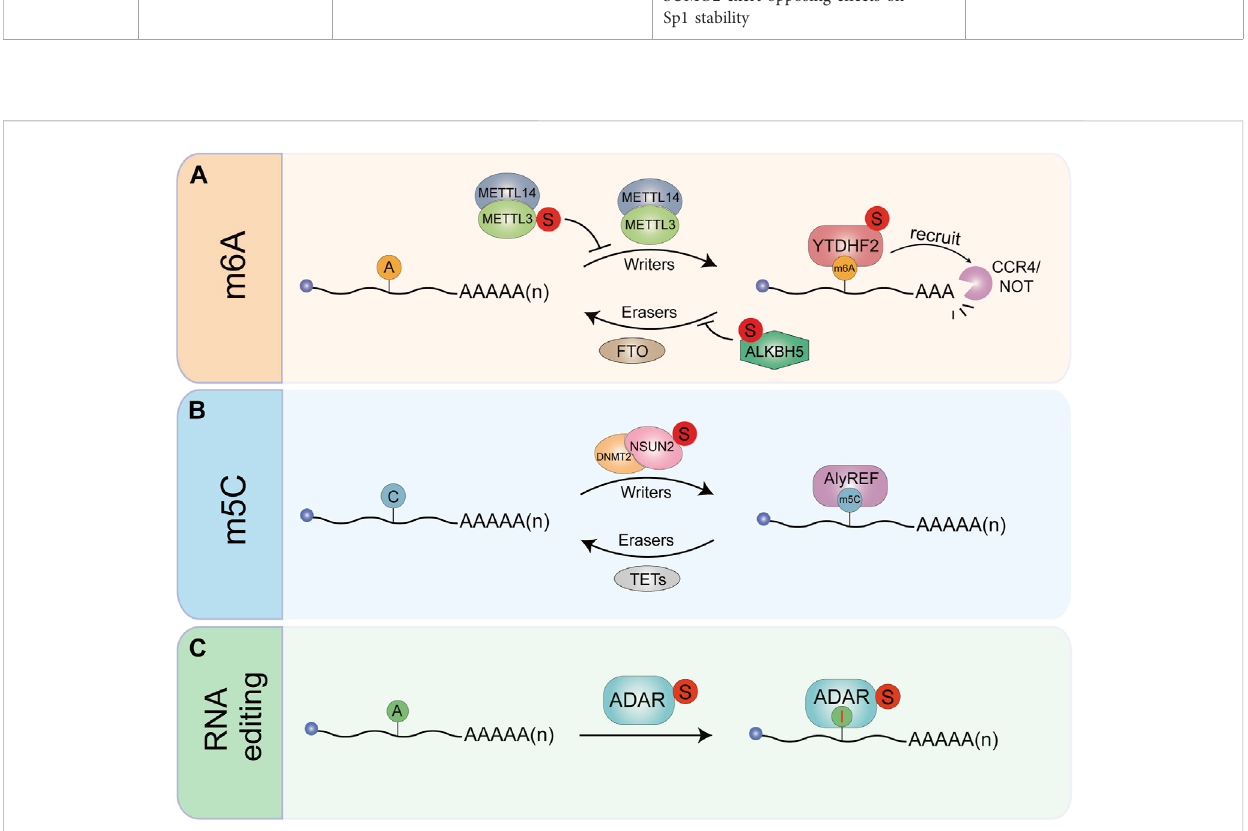
FIGURE 3 The effects of SUMOylation on RNA modi fi cation and RNA editing. (A) The N6-methylad-enosine writer METTL3. Reader YTHDF2 and eraser ALKBHS can be modi fi ed by SUMO. SUMOyIa-lion of METTL3 does not affect its stability. Subcellular localization. Or Interaction with MET11141 W-TAP. but signi fi cantly inhibits METTL3 m6A methyltransferase activity. YTHDF2 can be modi fi ed by SUMO1 under hypoxia. Enhancing its binding af fi nity to m6A-RNAs. Resulting in dysregulation of gene expression. ALKBHS SUMOylation loads to inhibition of ALKBHS m6A demethylase activity.